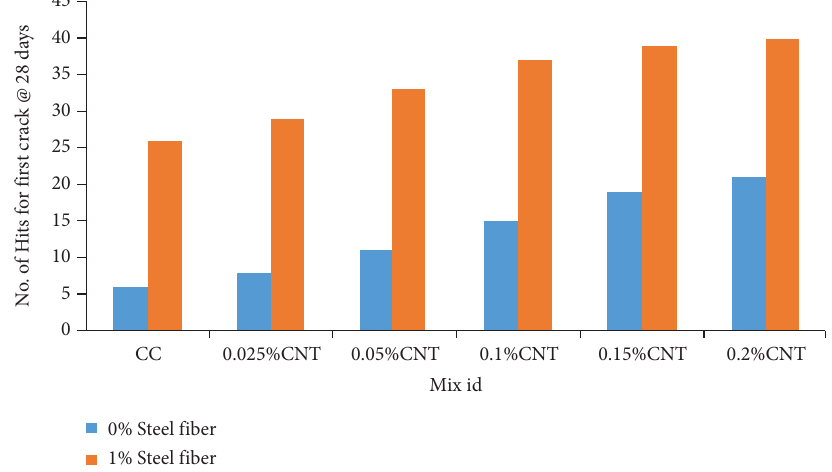
Figure 10: Number of impacts taken by specimens for frst crack development.